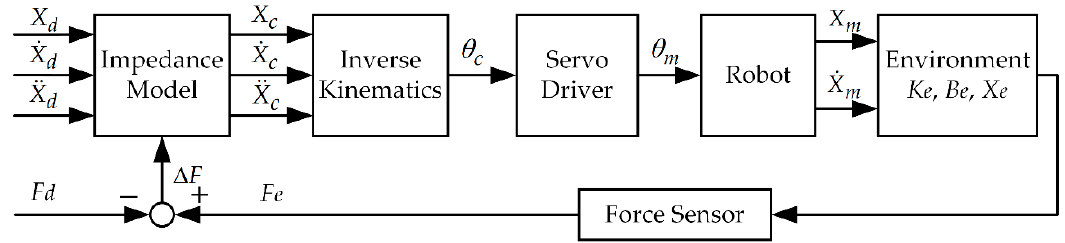
Figure 4. The position-based impedance control schematic.